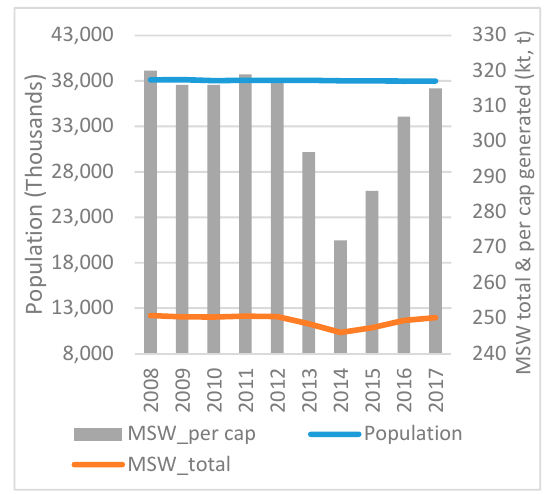
Figure 40. Waste treatment method and PPP in Austria 2008–2017 (EUROSTAT 2019b, 2019c).